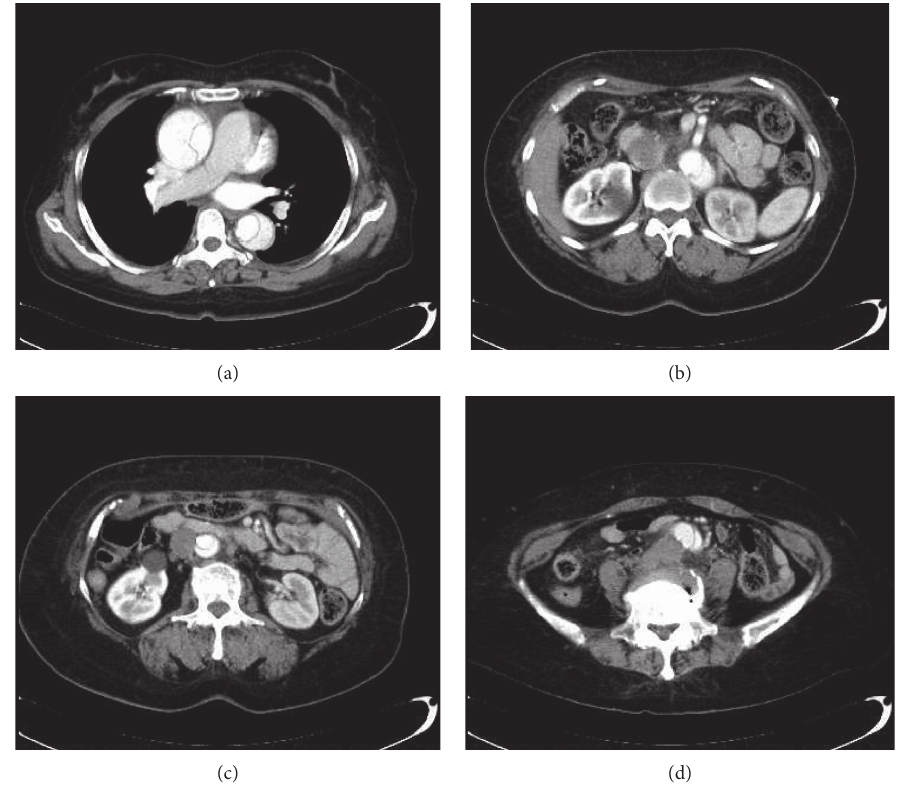
Figure 1: Preoperative enhanced computed tomography (CT) image shows (a) acute type A aortic dissection, (b) superior mesenteric artery perfusion from the true lumen, (c) left kidney not well enhanced, and (d) dissected lumen extending to the terminal